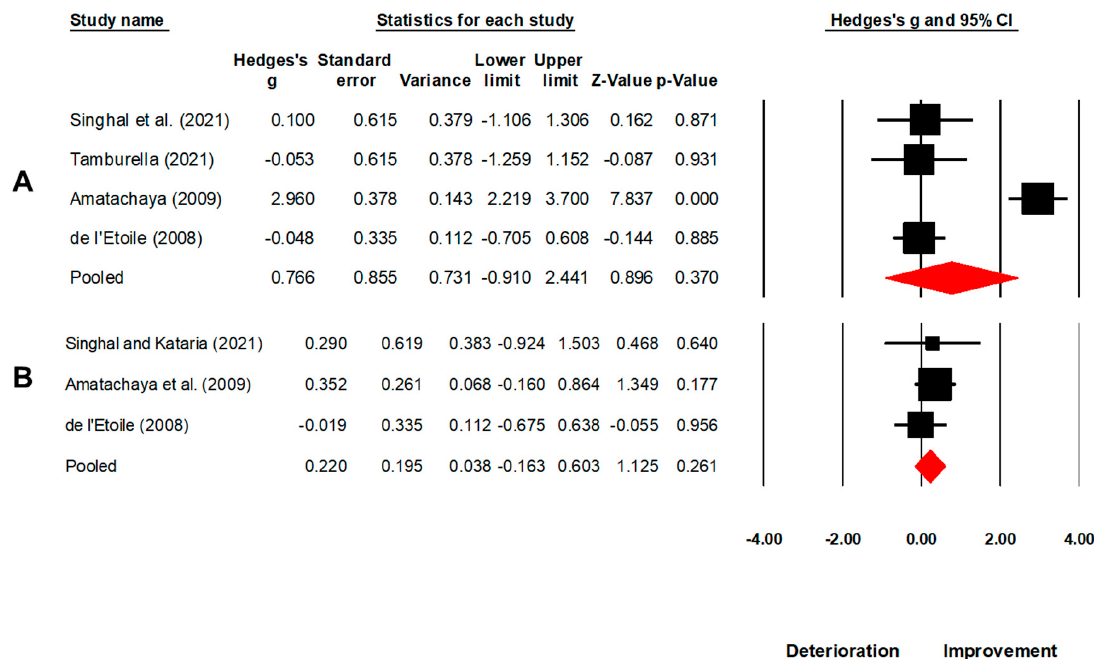
Figure 7. A forest plot depicts the impact of MT on ( A ) gait speed and ( B ) cadence in individuals with SCI. It includes individual weighted effect size Hedge’s g represented as black circles, and the whiskers represent the 95% confidence intervals. The pooled weighted effect size and 95% CI are presented at the bottom with a red diamond. A positive overall effect size in this analysis implies an enhancement in spatiotemporal outcomes of gait with MT, while a negative overall effect indicates a decline in spatiotemporal outcomes of gait with MT. Refs [60,61,64,66] mentioned.